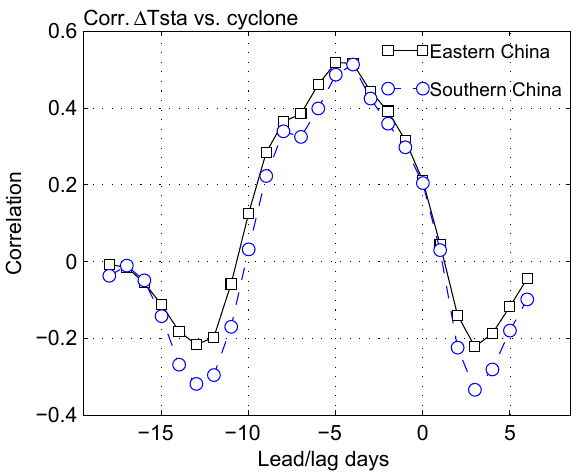
Figure 11. Correlations of the 500hPa geopotential heights over the anomalous cyclone center (140–145 ◦ E and 25–35 ◦ N) on day + 5 with the regional mean temperature over eastern (southern) China in varying lead or lag